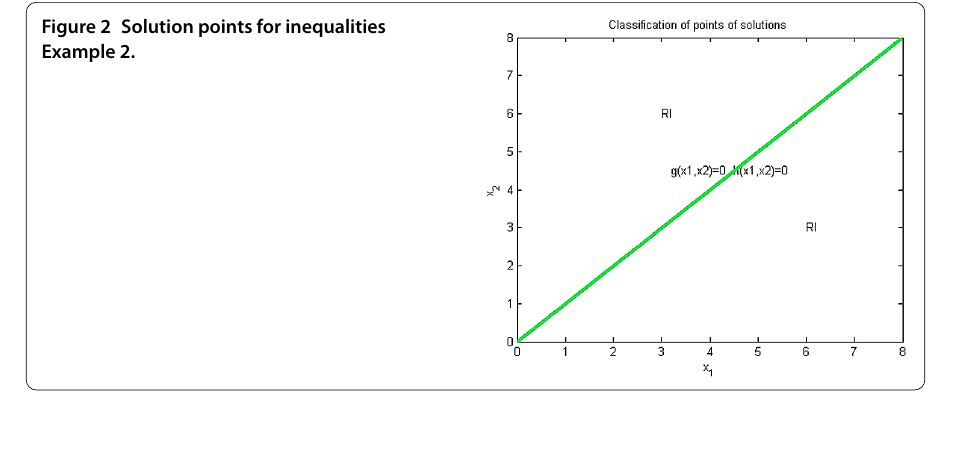
Figure 3 Solution points for inequalities Example